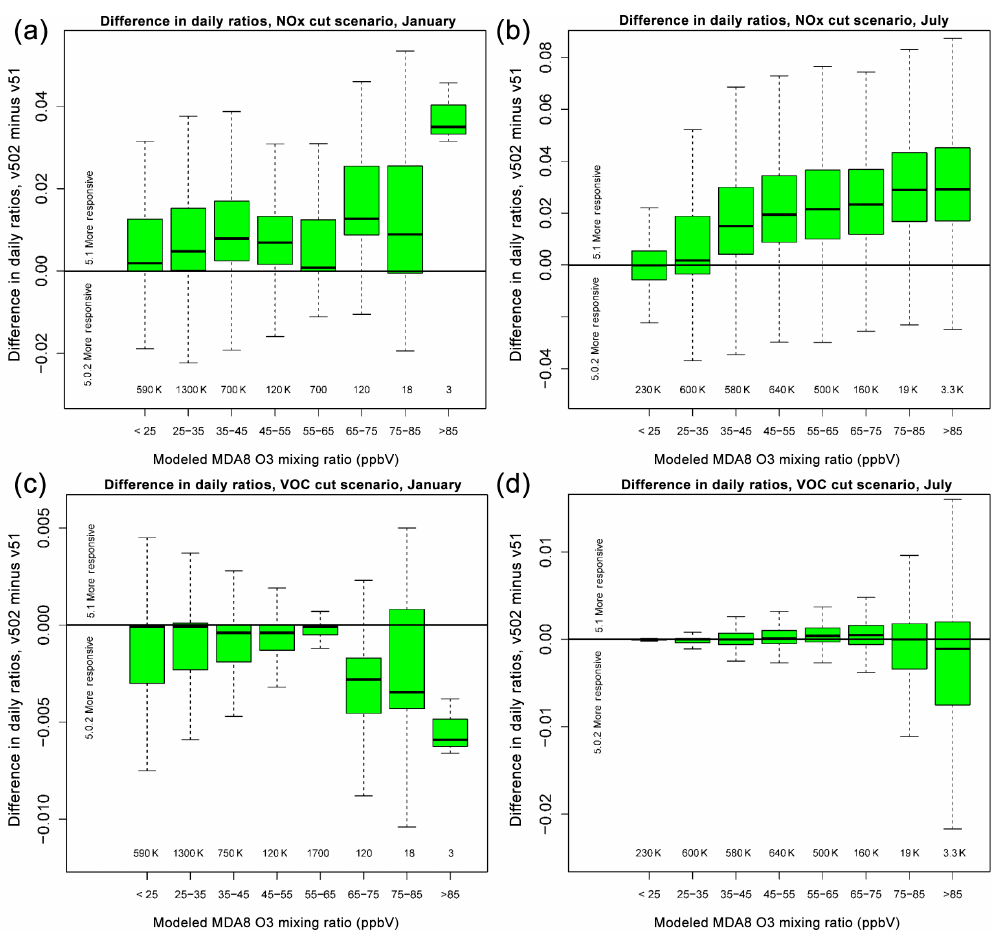
Figure 17. Difference in MDA8 O 3 daily ratios (cut scenario / base) for CMAQv5.0.2 and v5.1 (v5.0.2–v5.1) for a 50% cut in anthropogenic NO x (a–b) and VOC (c–d) for January (a, c) and July (b, d) binned by the modeled MDA8 O 3 mixing ratio (ppbv). Values greater than 1 indicate v5.1 is more responsive than v5.0.2 to the emissions cut, while values less than 1 indicate v5.0.2 is more responsive. Given above the x axis is the number of model grid cells in each